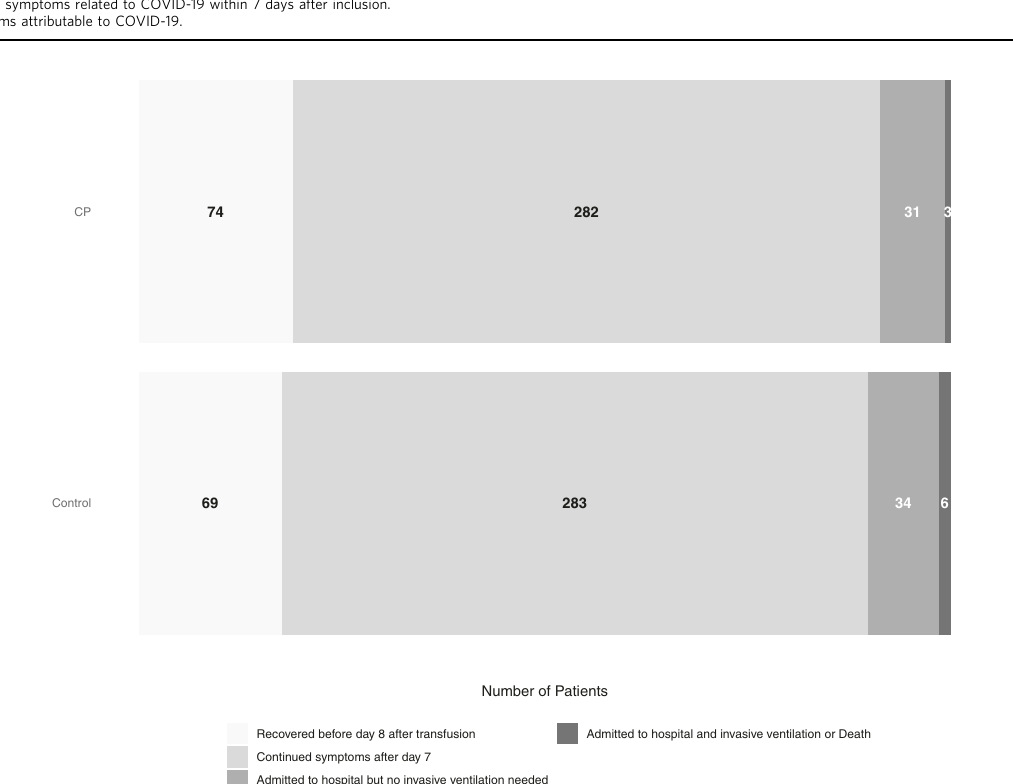
Fig. 2 Distribution for COVID-19 severity at 28 days. CP Convalescent plasma. Figure shows the distribution of the outcome of the patients in the 28 days after inclusion across the 5-point disease severity scale: 1 = recovered before day 8 after transfusion, 2 = continued symptoms after day 7, 3 = hospital admission, 4 = invasive ventilation, 5 = death. Moving from lighter to darker shading represents increasing scores on the severity scale. The darker shade includes point 4 and 5 of the scale (invasive ventilation or